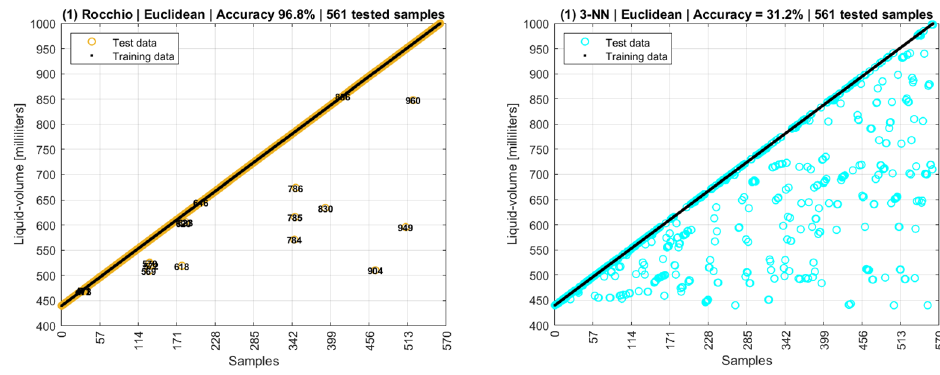
Figure 18. Rocchio and k-NN accuracies with centroids of mode values.